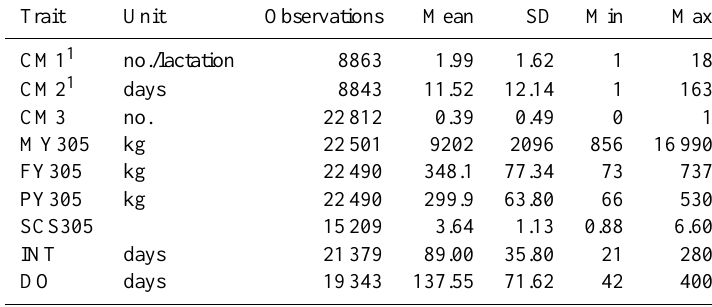
Table 2. Descriptive statistics of CM traits, SCS, milk production, and fertility. Trait Unit Observations Mean